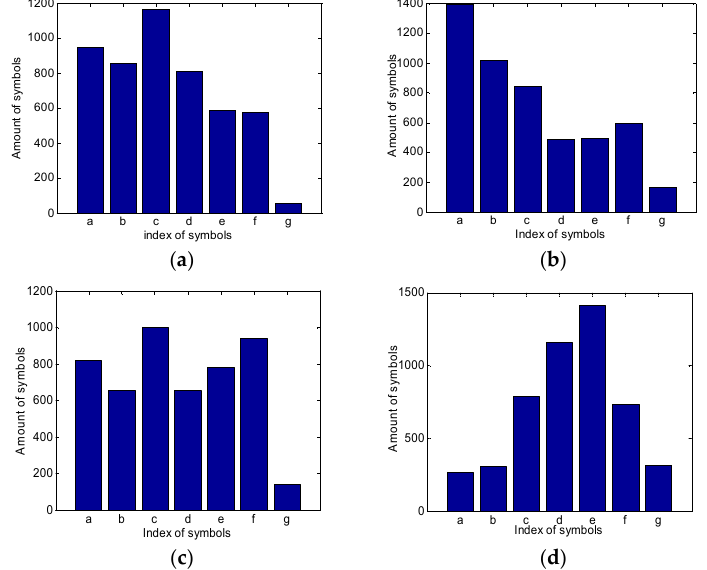
Figure 13. Symbol distribution of each operating condition: ( a ) Condition 1; ( b ) Condition 2; ( c ) Condition 3; and, ( d ) Condition 4.